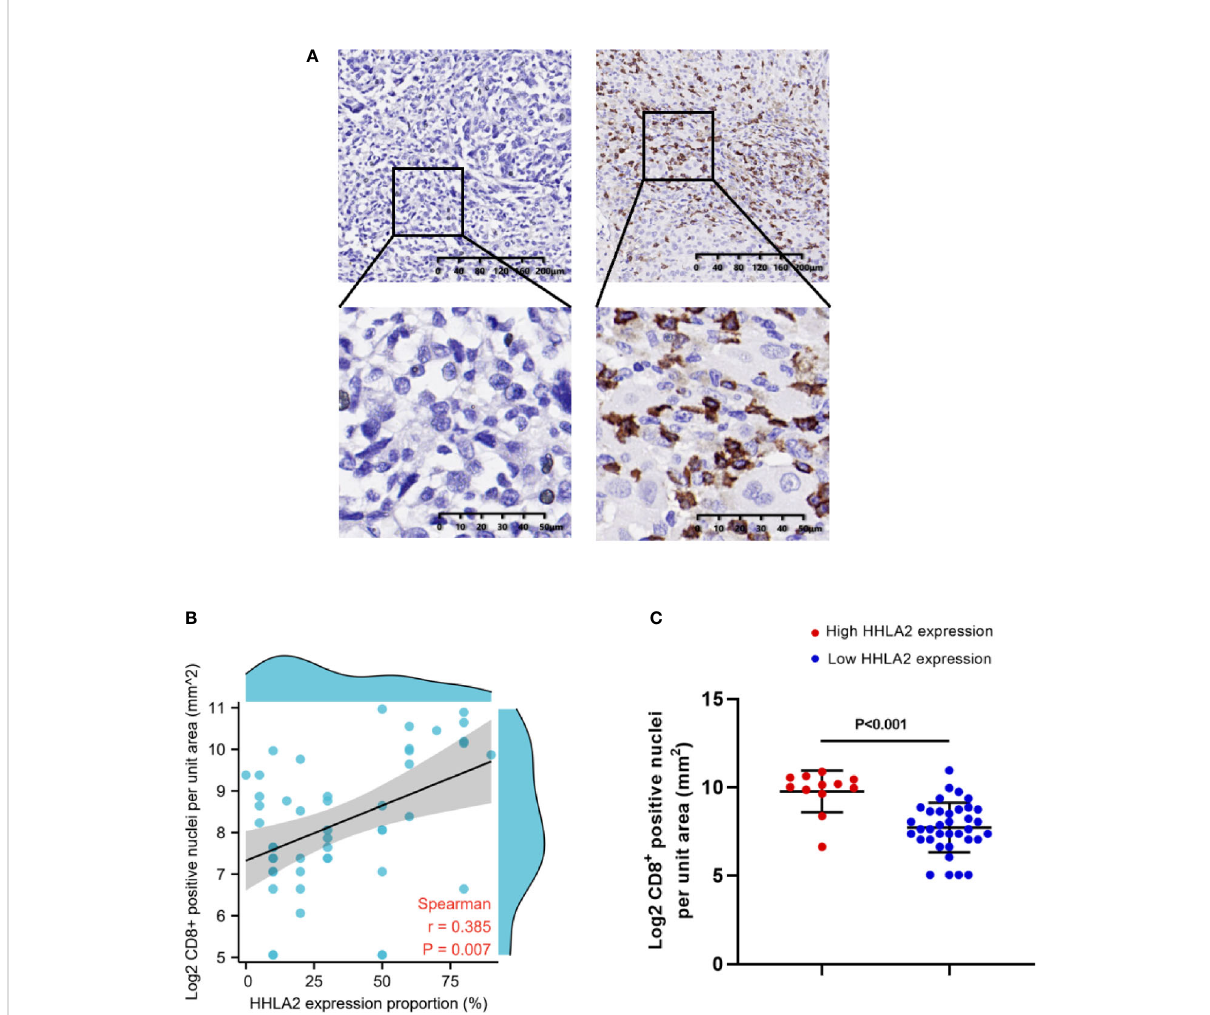
FIGURE 6 The association between tumor in fi ltrating CD8 + T cells and HHLA2 expression. (A) Representative micrographs of CD8 expression and the corresponding negative controls in tumors. (B) The association between HHLA2 expression and CD8 + T cells (Spearman r=0.385, p=0.007). (C) Higher HHLA2 expression was signi fi cantly correlated with more intra-tumor CD8 + T cells (unparalleled t-test, p<0.001). P values <0.05 are in